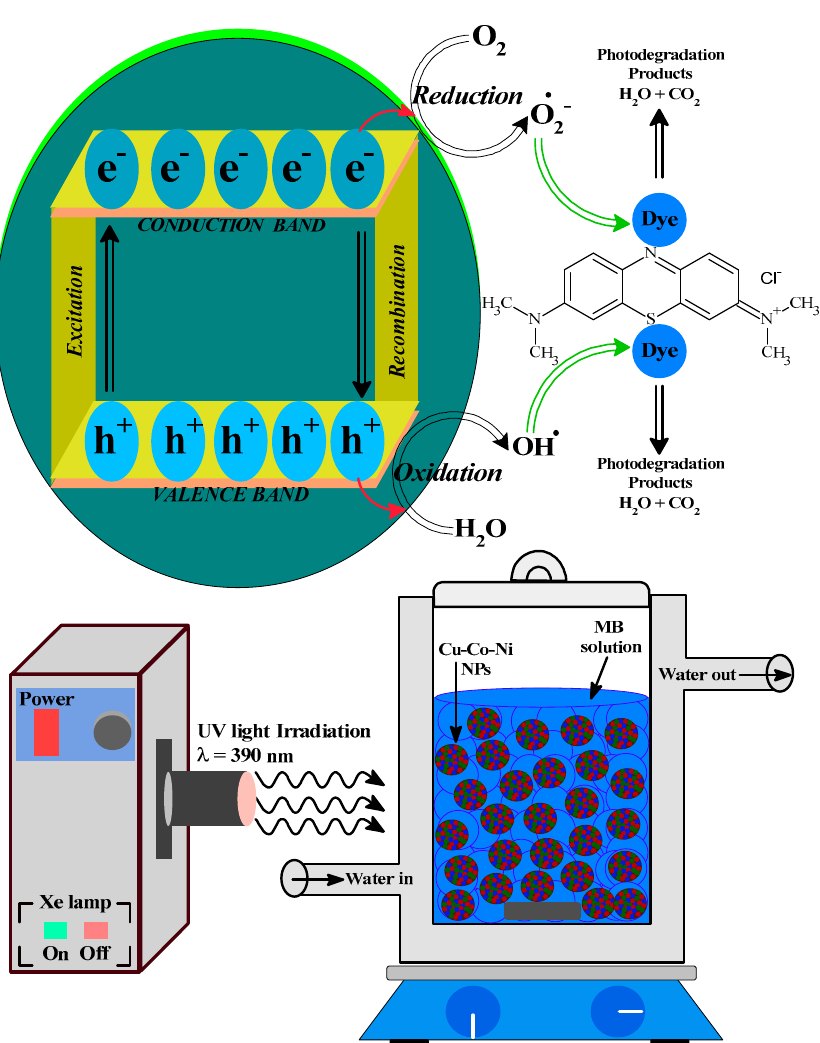
Figure 11. Possible mechanism of photodegradation of MB by Cu-Co-Ni nanoparticles.